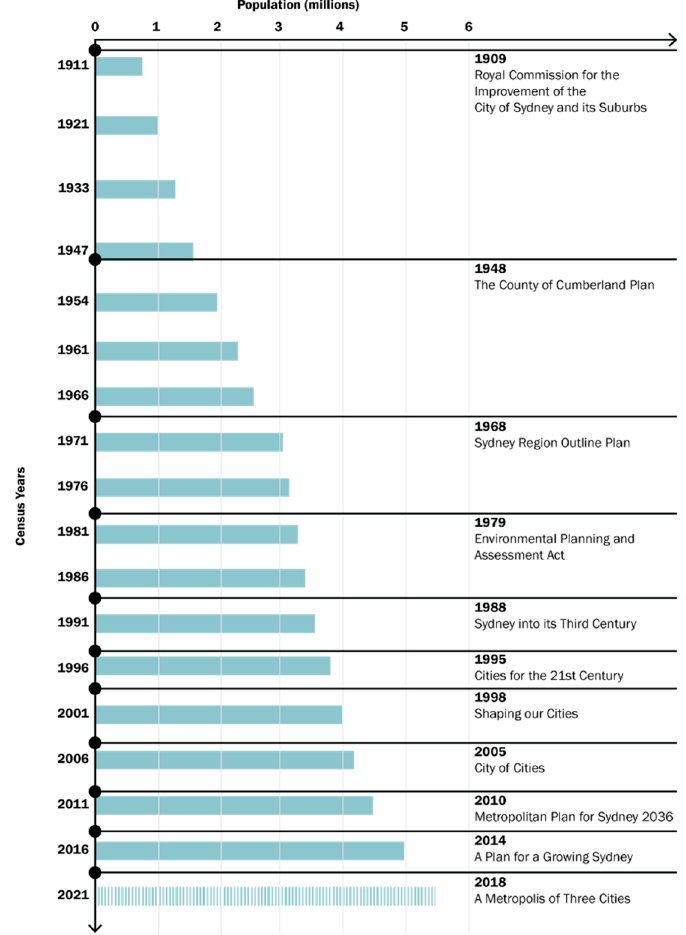
Figure 1. Population growth and key strategic plans in Greater Sydney Region 1911–2021.